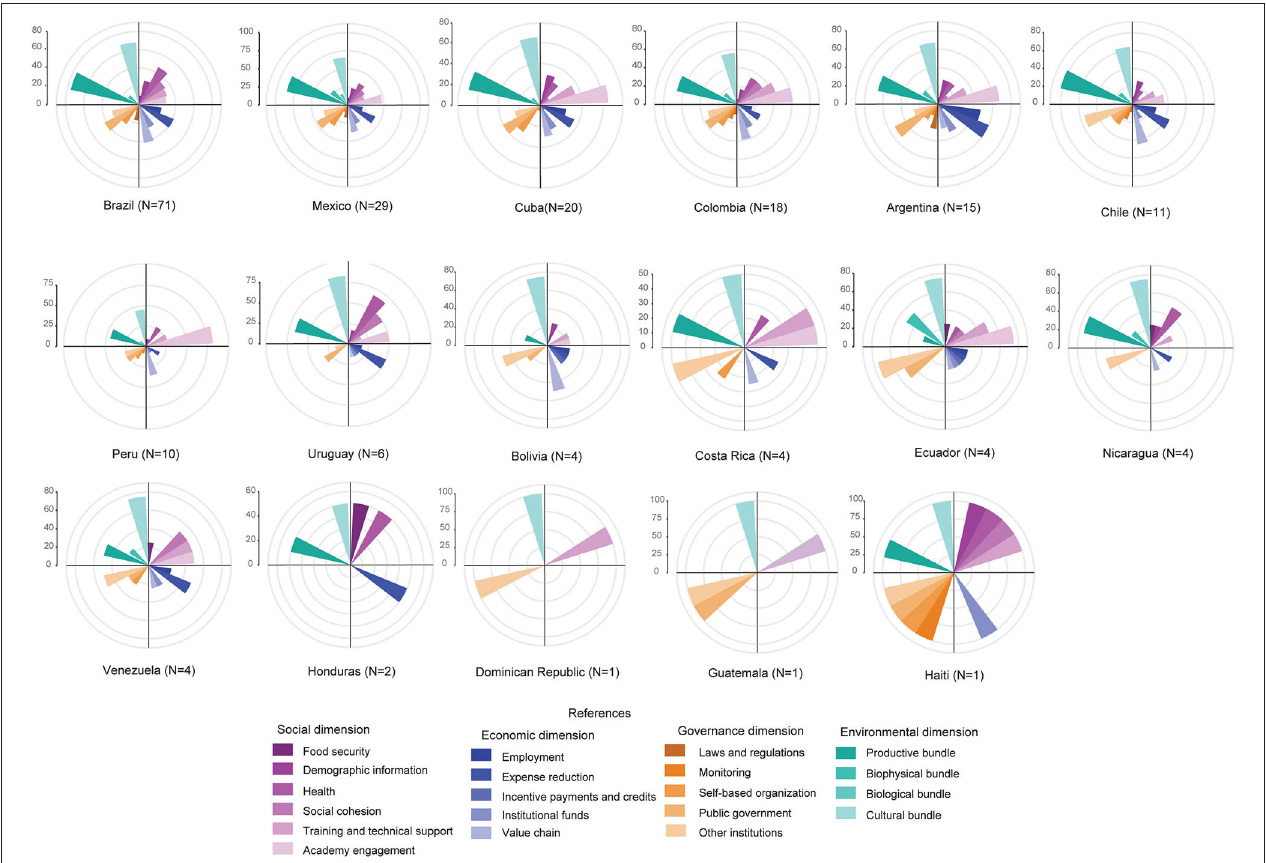
FIGURE 3 | Projections of ecosystem service bundles, benefits, stakeholders, and drivers over the four dimensions of sustainable